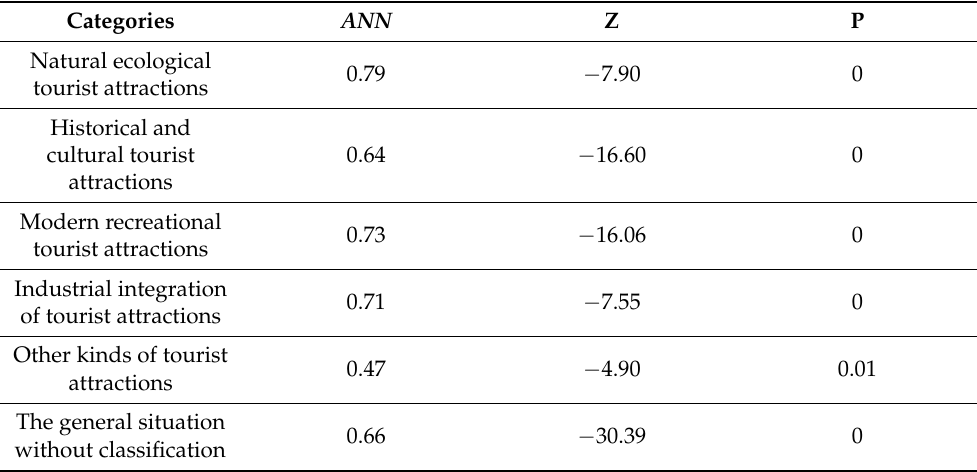
Table 3. Results of average nearest neighbor analysis of tourist